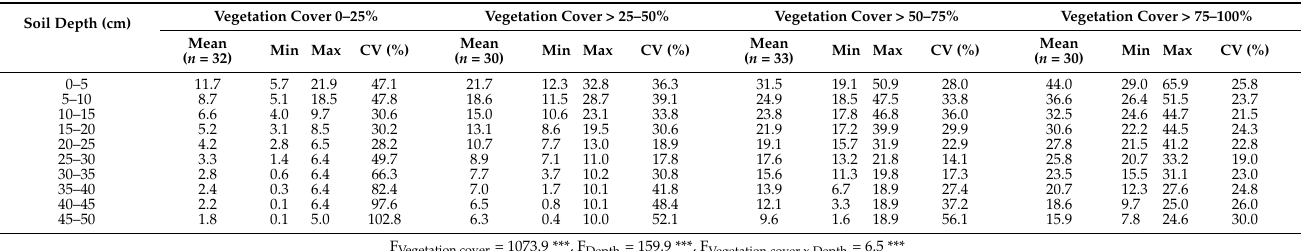
Table 2. Summary of statistics of soil organic carbon contents (g C/kg) at different depth intervals in ten sites of sabkhas with different vegetation covers along the southern Red Sea coast of Saudi